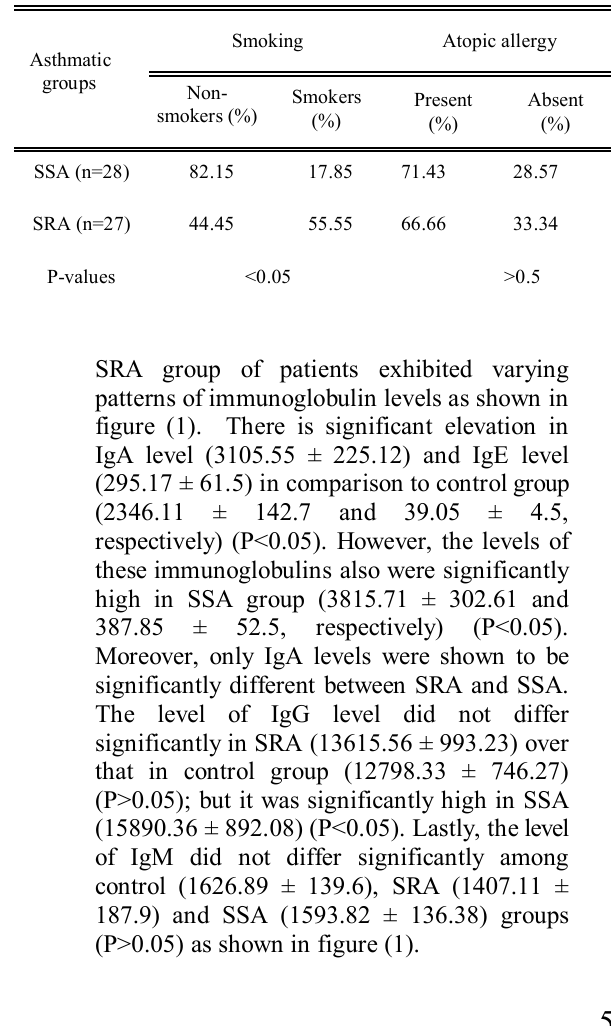
Table (3): Smoking habit and atopic allergy among steroid resistant and steroid sensitive asthmatic patients.